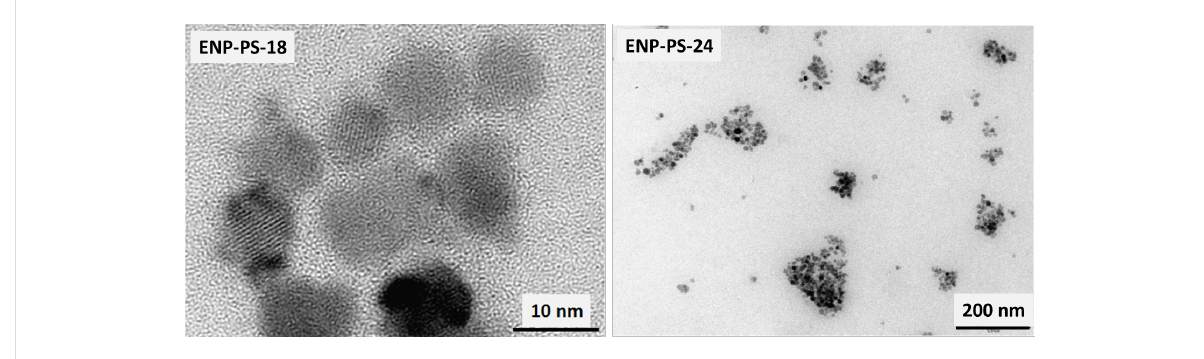
Figure 5: TEM images of ENP-PS-18 (left) and ENP-PS-24 (right).